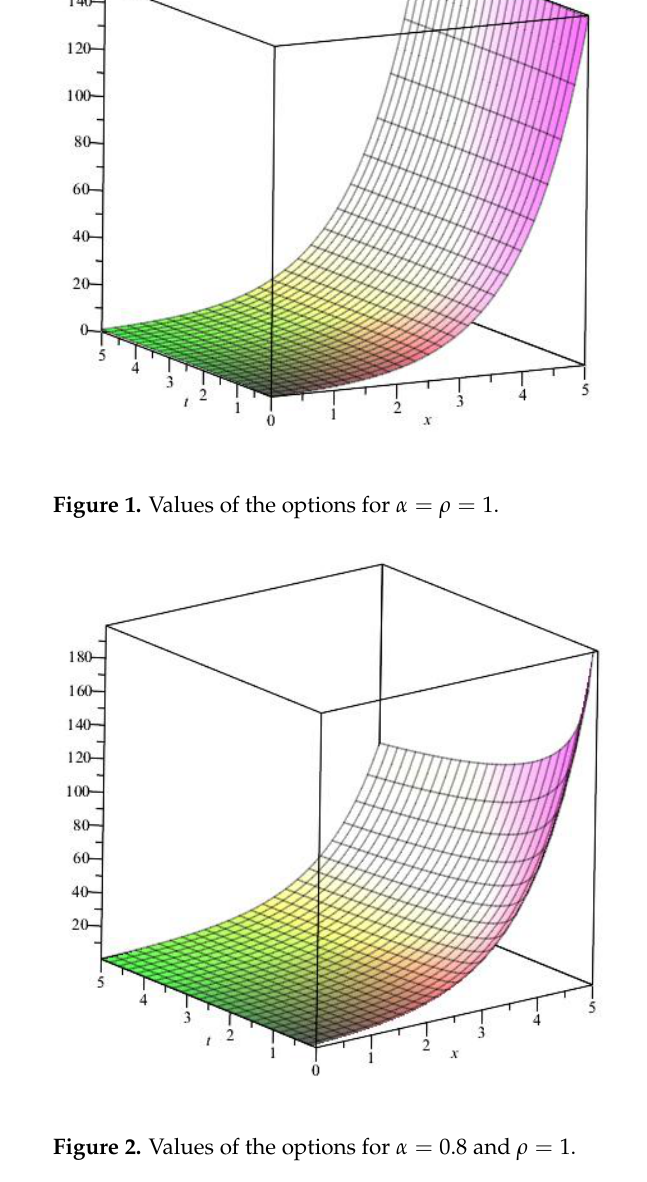
Figure 2: Values of the options for α = 0.8 and ρ = 1 Figure 2. Values of the options for α = 0.8 and ρ = Table 1. Values of European option with the different vaules of ρ order ( α )